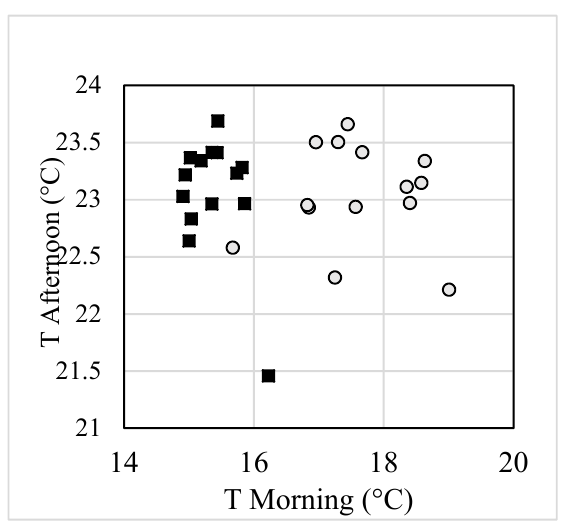
Figure 7. Scatter plot of morning and afternoon temperatures for external (circles) and internal (black squares) rows.